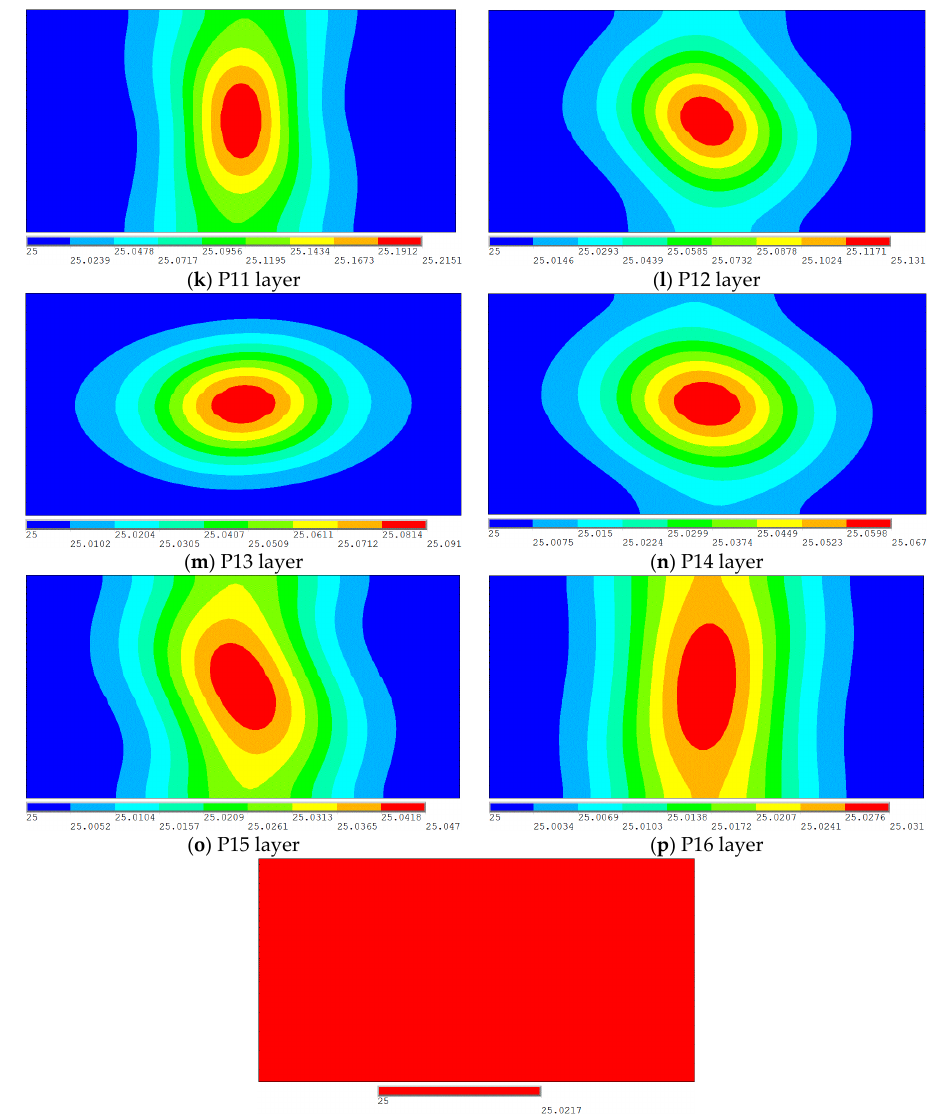
Figure 8. Temperature distribution of the top 17 layers in the benchmark skin of the composite reinforced panel. (Unit: °C).